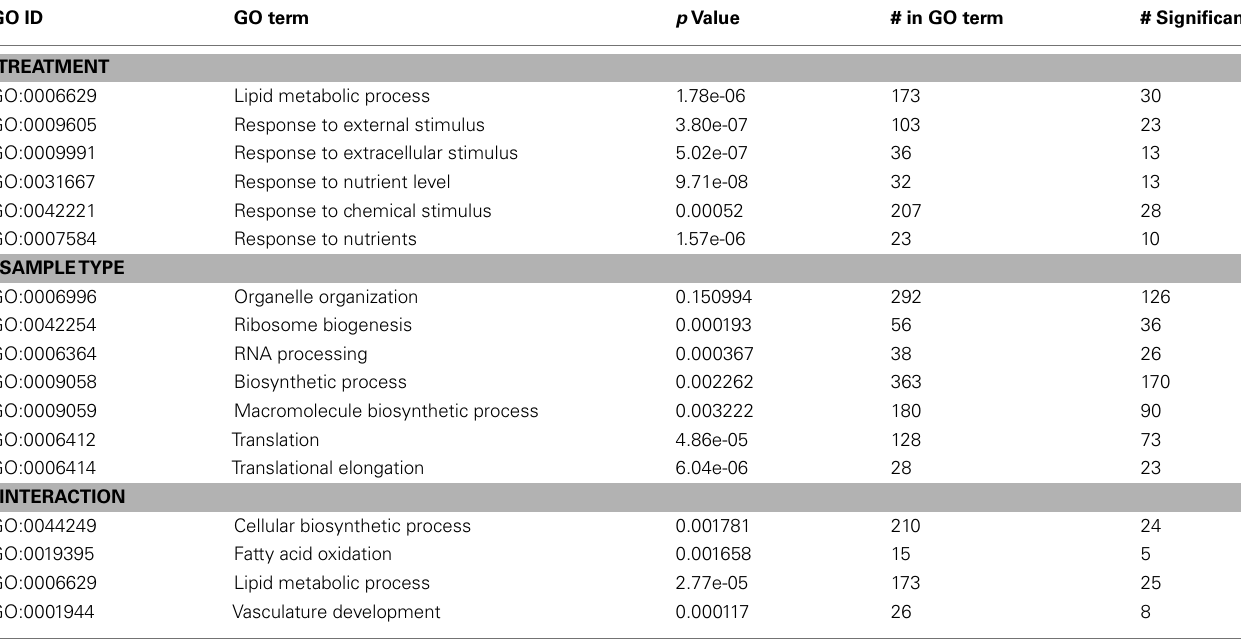
Table 1 | Gene Ontology (GO) terms for biological processes that are over represented in the lists of significant transcripts and their P -values as obtained using the R package topGO (Alexa et al.,